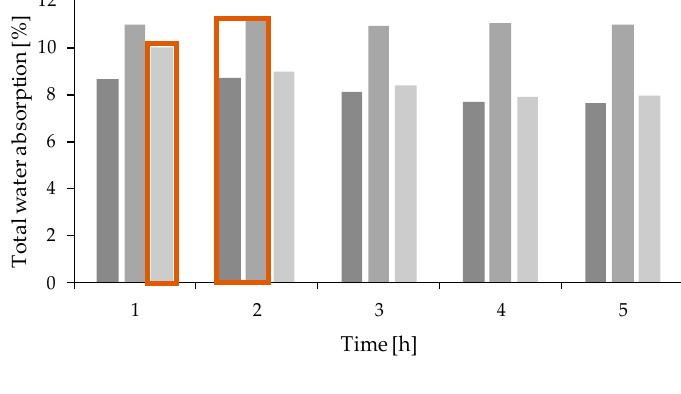
Figure 11. Total water absorption results. The results highlighted by the orange box represents the maximum values obtained in the total water absorption test.